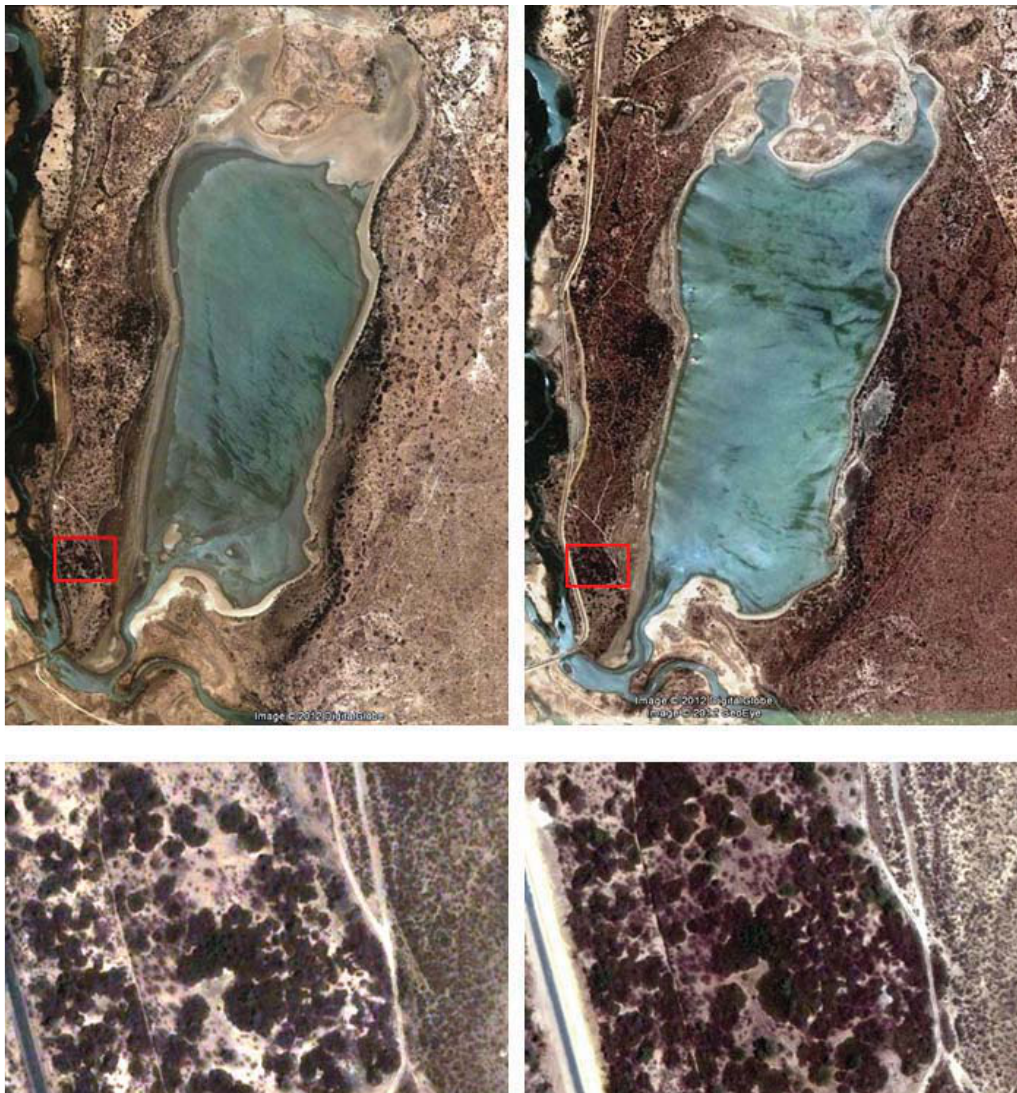
Figure 2. Photos showing changes occurred in vegetation cover in RF Guembeul: left side pictures taken in 13 March 2003; right side pictures taken in 5 April 2011. General view is shown above; details of plots in red, below. Photos have been taken from Google©; accessed on 28 May